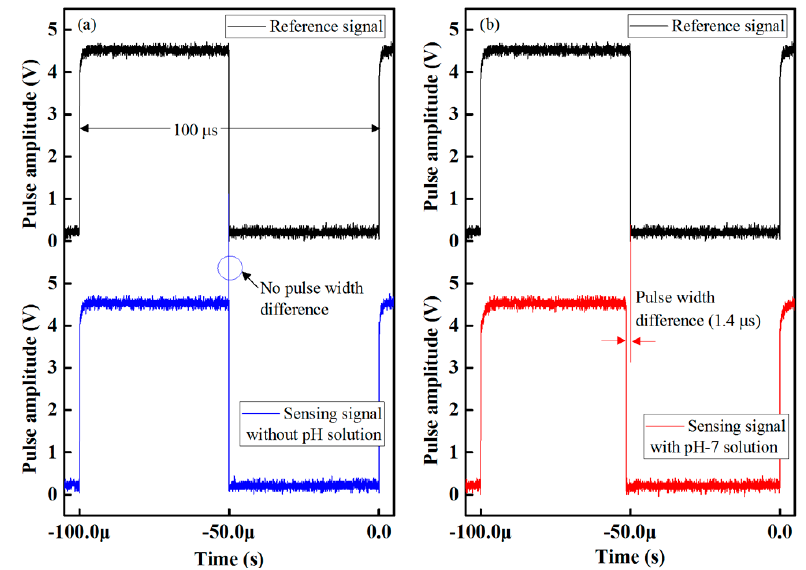
Figure 5. Waveform response of the proposed optical-fiber PWM pH-sensing system: ( a ) without buffer solution; and ( b ) with buffer solution at pH 7 for methyl red containing optical-fiber sensing element of the array.